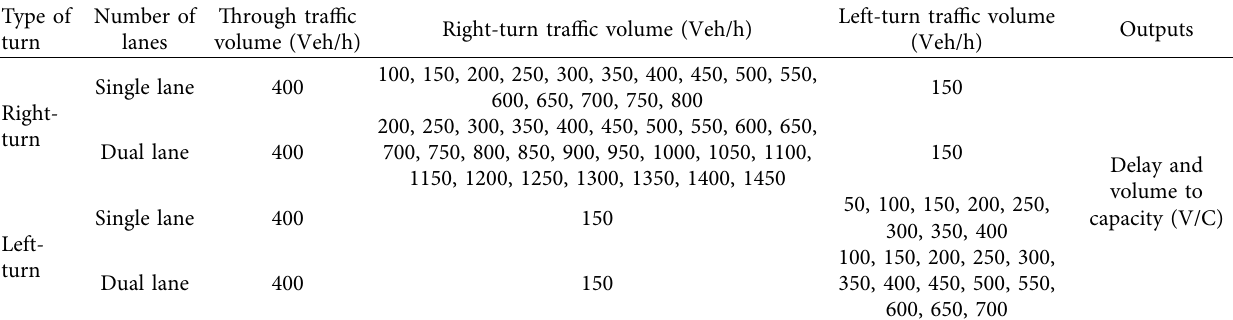
Table 2: Summary of scenarios, trafc demand volume, and